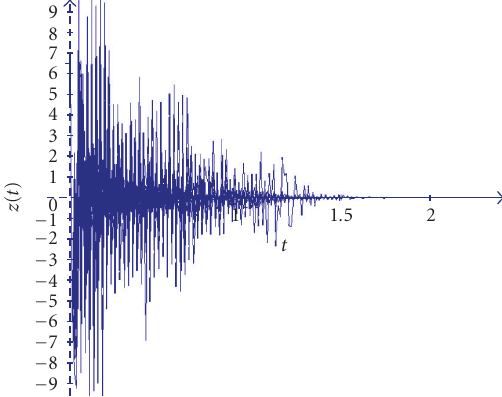
Figure 7.6 . Stable solution of (5.2) in the point Y (465,100), a 0 = 6 .